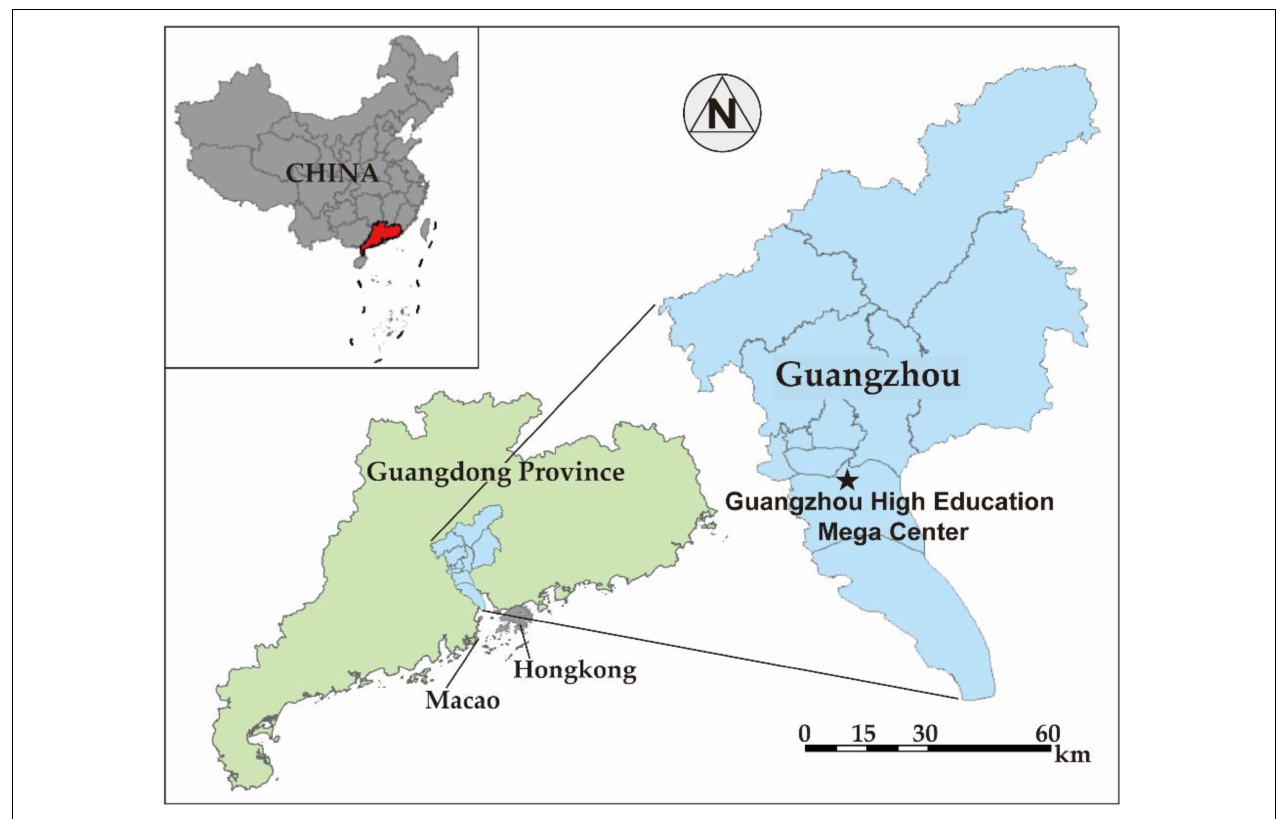
FIGURE 1 | The studied area, located in a green experimental field at Guangzhou University,